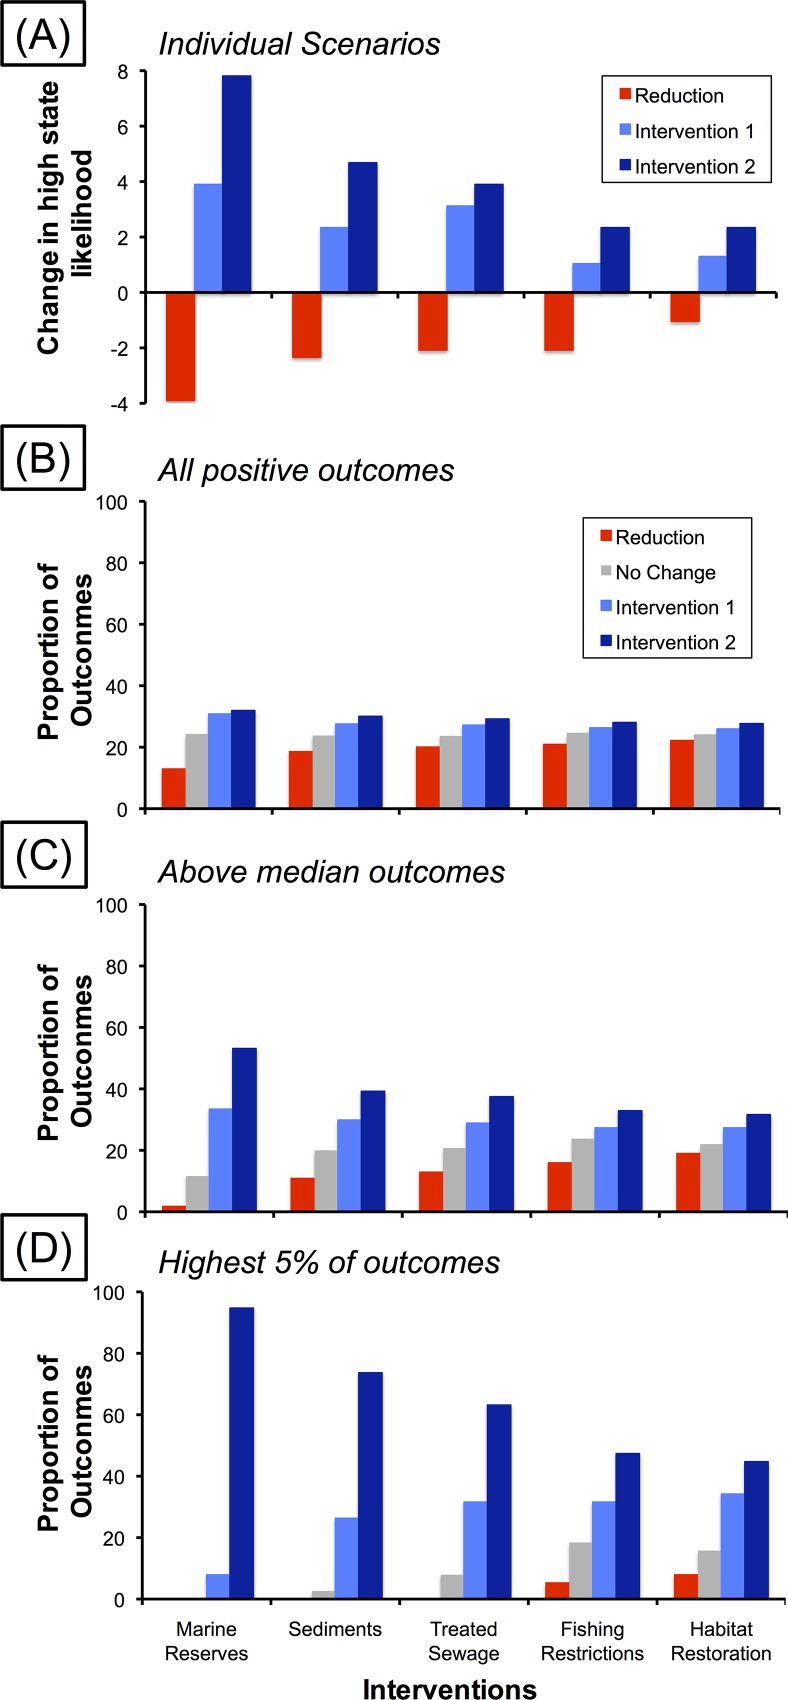
Performance of management actions: (A) likelihood of a change in state when only a single action is implemented); (B) the proportion of outcomes that resulted in positive effects on coral reef condition; (C) the proportion of outcomes that resulted in above median effects on coral reef condition; and (D) the proportion of outcomes that resulted in the highest 5% of positive effects on coral reef condition. See Table 1 for full details of each management option.